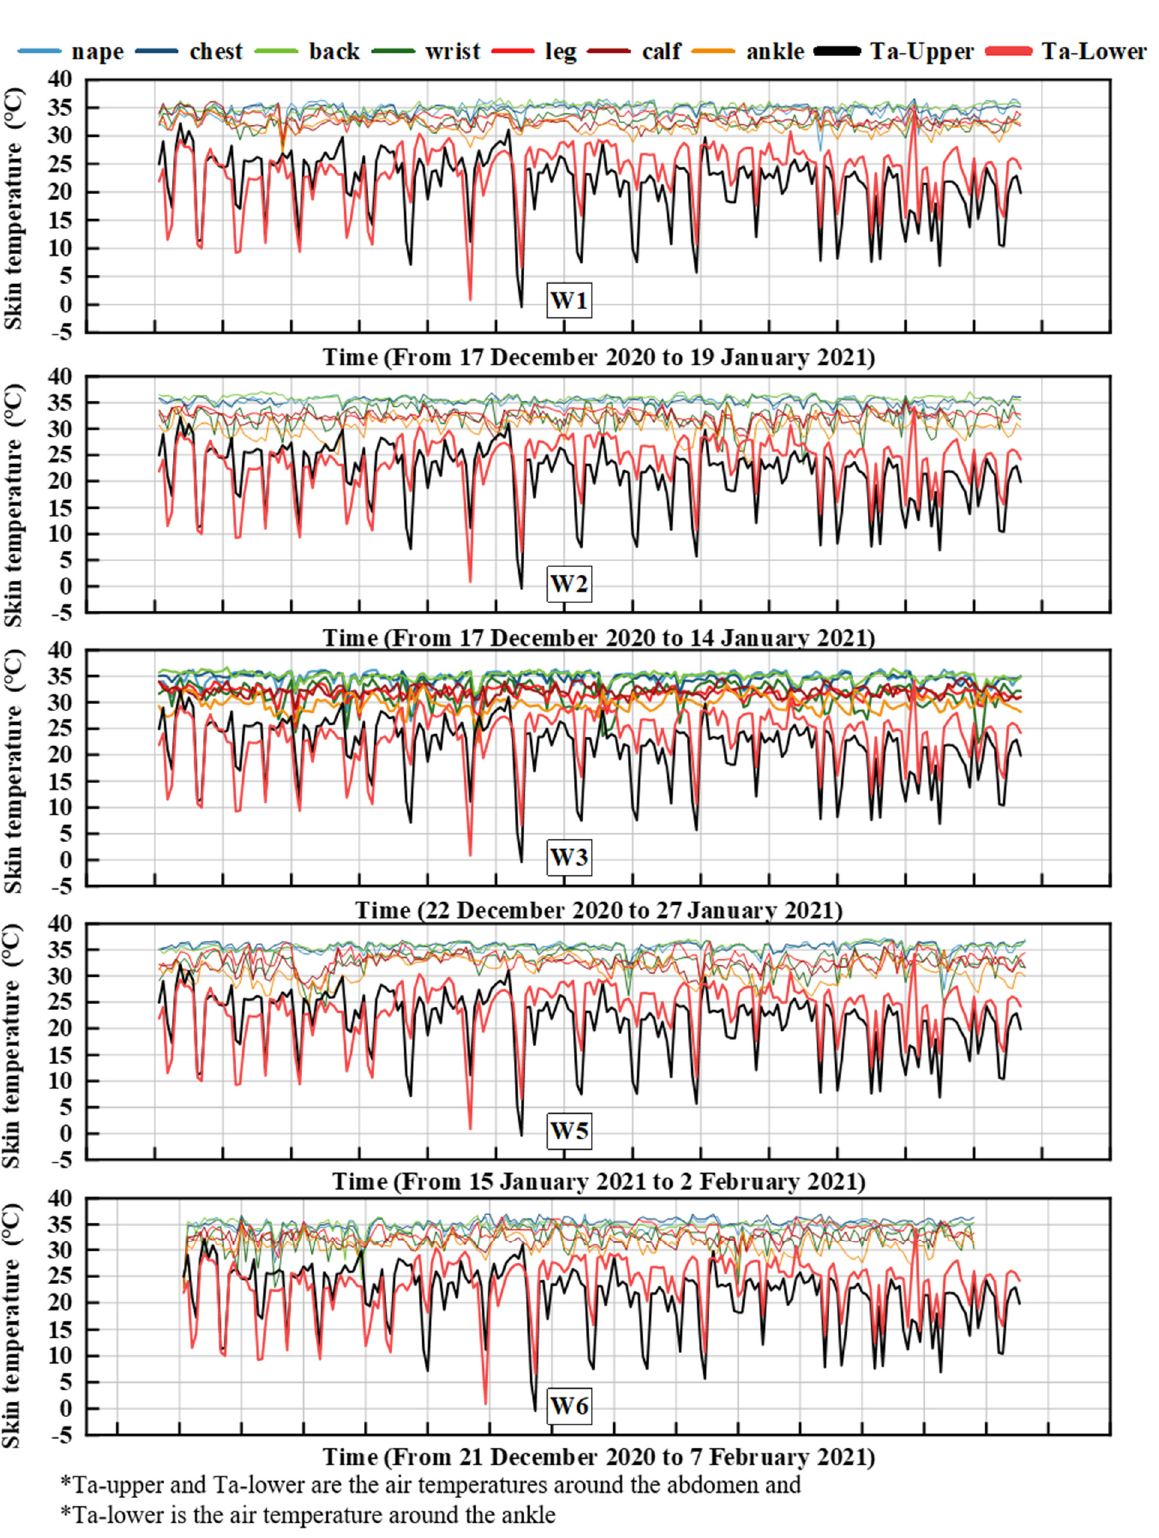
Figure 5. The thermal experiences of the subjects.